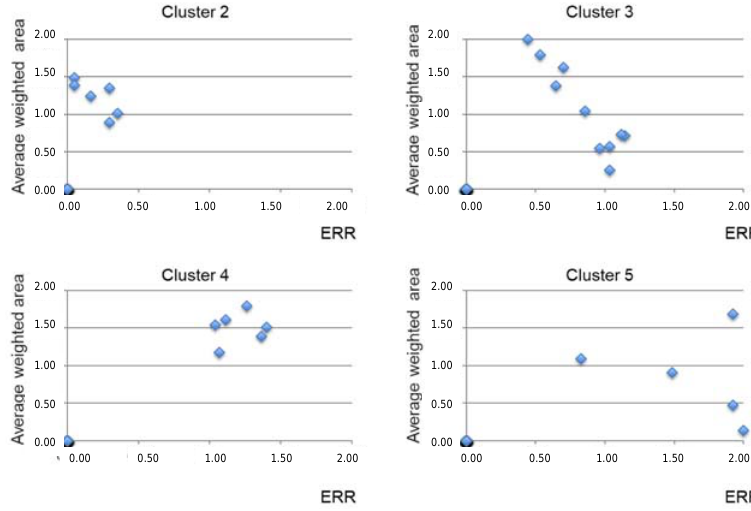
Figure 13. Trade-off between variables on a reduced sample.